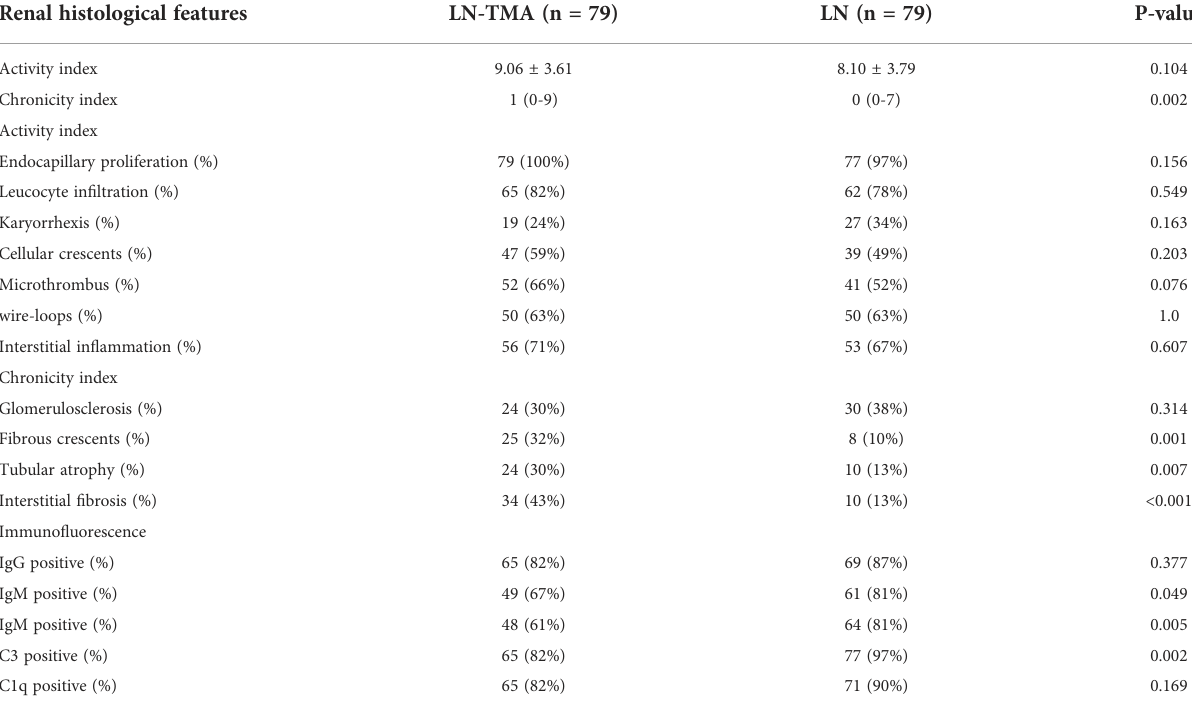
TABLE 3 Renal histological features in lupus nephritis patients with or without thrombotic microangiopathy. Renal histological features